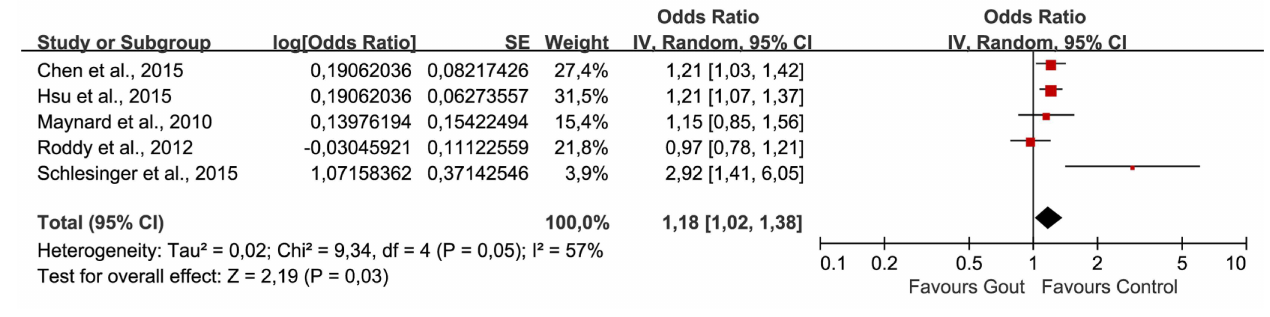
Fig 3. Forest plot of gout and ED: adjusted OR.